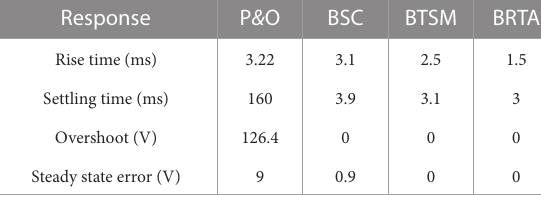
TABLE3 ComparisonofPVvoltagetracking.